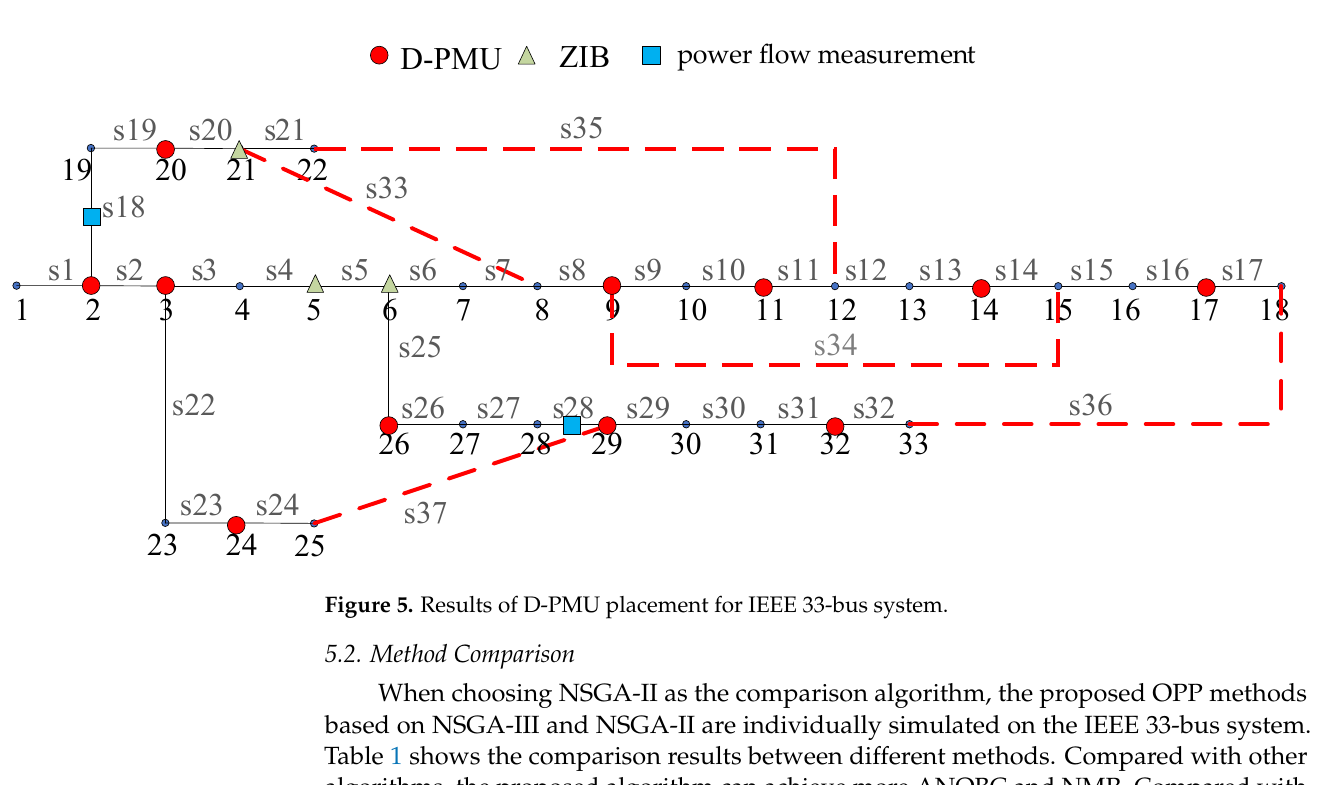
30 Figure 4. The Pareto set and the compromised optimal solution. According to Figure 4, considering SCADA, ZIB and two topologies, the compro- mised optimal solution of OPP requires 11 D-PMUs. Through the D-PMU placement or- der determination method in Section 4, the order of placing D-PMUs is given, which can maximize the state estimation accuracy of each installation stage. The D-PMU placement order according to the sequential calculation method is: 3, 26, 14, 9, 17, 20, 29, 32, 11, 2, 24. Figure 5 shows the application result of the proposed method for the IEEE 33-bus system. The D-PMU of bus 2 can observe bus 1, 2, 3 and 19; the D-PMU of bus 3 can ob- serve bus 4 and 23; and the D-PMU of bus 26 can observe bus 6, 26 and 27; bus 9, 11, 14 and 17 can observe bus 8 to 18; the D-PMU of bus 20 can observe bus 20 and 21; the D- PMU of bus 24 can observe bus 23 and 25; and the D-PMU of bus 29 and 32 can observe bus 28 to 33. Because bus 4 and 6 are observed, and because bus 5 has injection power measurement equipment, bus 5 is observed. Similarly, 7 and 22 are observable based on the D-PMUs of bus 5, 6 and 26 and of bus 20 and 21, respectively. So far, the whole topol-